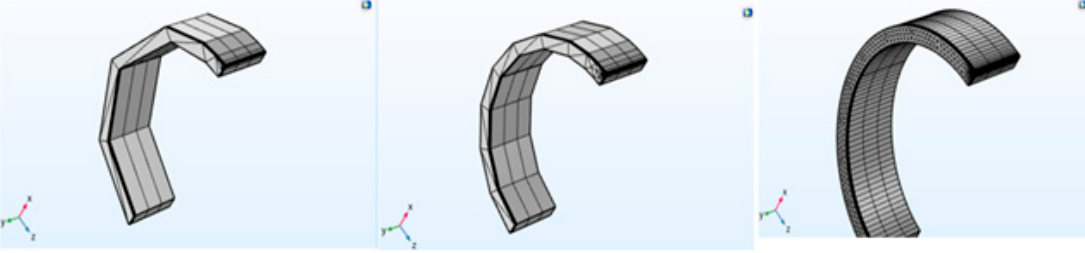
Figure 10. Mesh refinement moving from an extremely coarse mesh with 5291 elements ( left ), normal mesh with 6030 elements ( middle ), to an extremely fine mesh with 15,158 elements ( right ) .